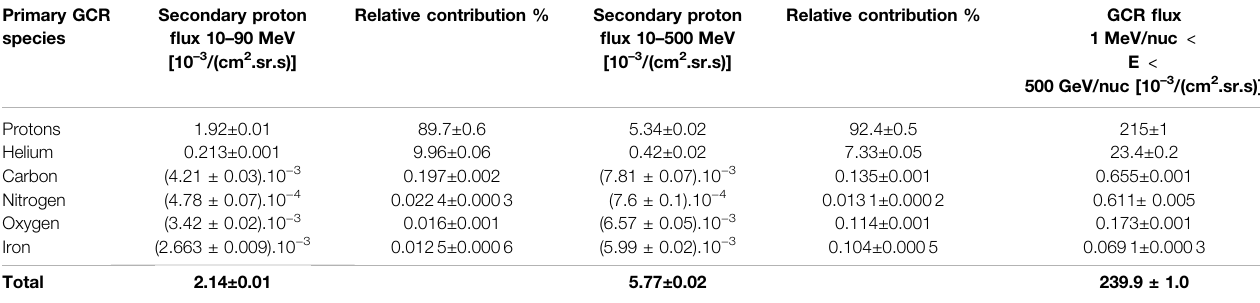
TABLE 2 | Secondary protons integral fl uxes predicted with dMEREM for Gale Crater, for two energy domains — the 10 – 90 MeV interval corresponding to the RAD measurements — for the conditions of the period from November 2015 to 15/01/2,016 and based on the ISO-15390 model. The proton fl uxes at the surface and their relative abundances are shown for the primary GCR species originating them. The corresponding integral fl uxes of primary particles are also shown. Uncertainties are statistical